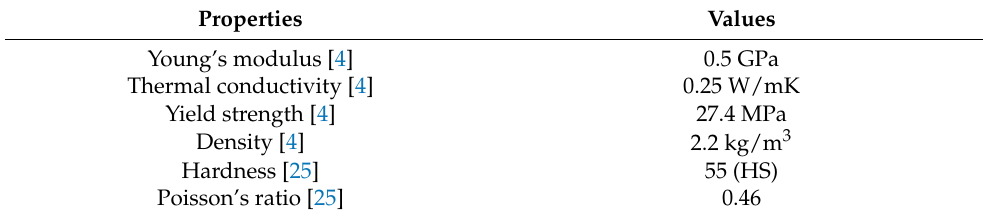
Table 1. Mechanical characteristics of the